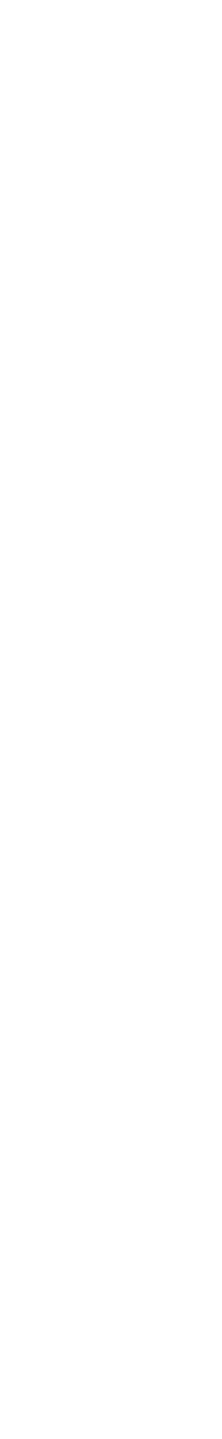
fusion genes have been con fi rmed in the relevant literature. The Sanger